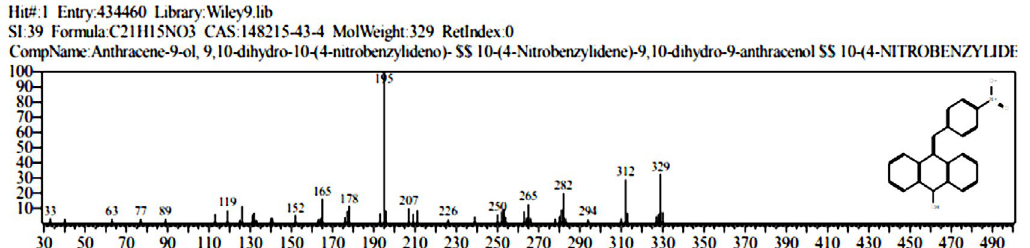
Fig. 14. Chromatogram of chemical compounds Anthracene -9-Ol, 9,10-Dihydro-10- (4-Nitrobenzylideno) - (Functional Group - Ol / Alcohol)